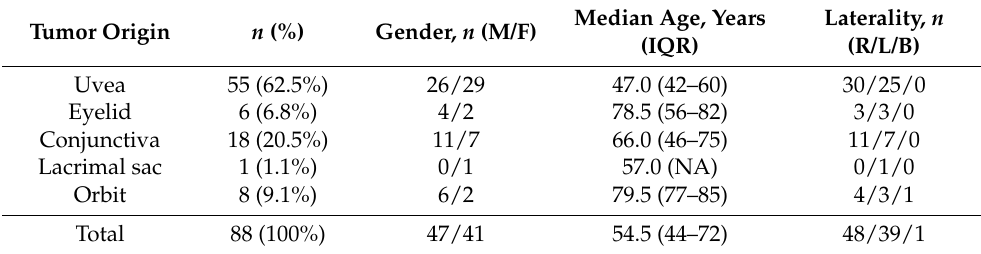
Table 1. Demographics of subjects with ocular